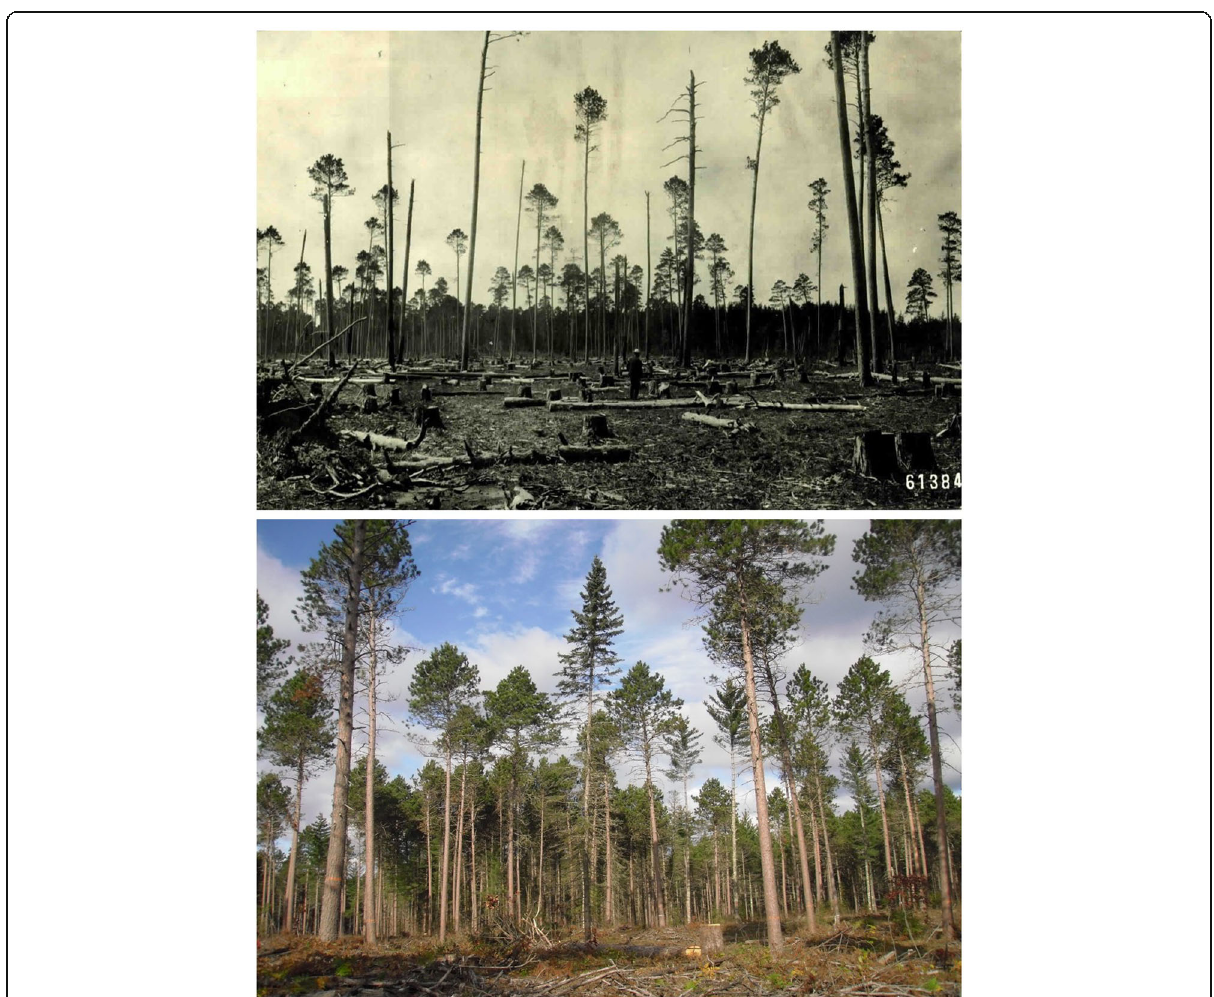
Fig. 5 Top: Poor quality and low level of retention after an early regeneration harvest on the Chippewa National Forest, MN, USA (circa early 1900s). Bottom: Higher quality and higher density of retention trees after a VRH on the same national forest (circa